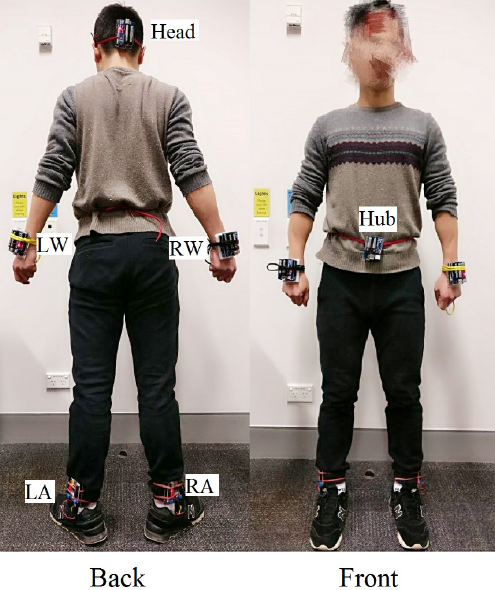
Figure 3. Components of the portable transceiver.